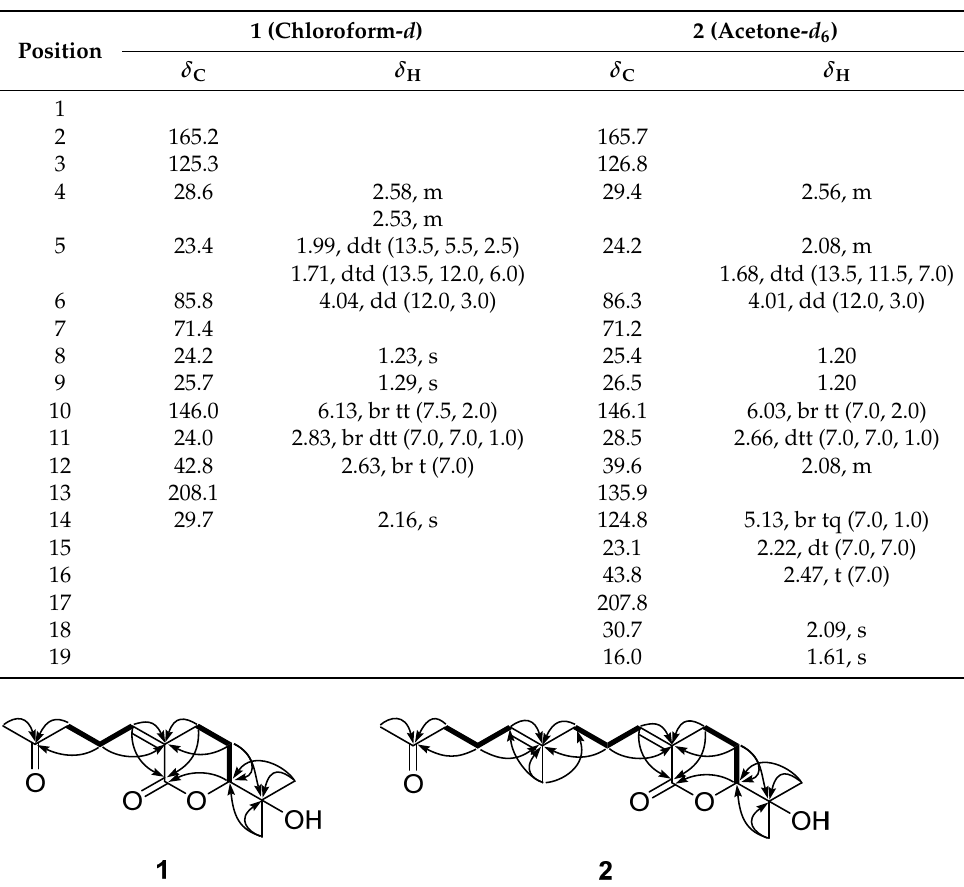
Table 1. 1 H (600 MHz) and 13 C (150 MHz) nuclear magnetic resonance data of compounds 1 and 2 .